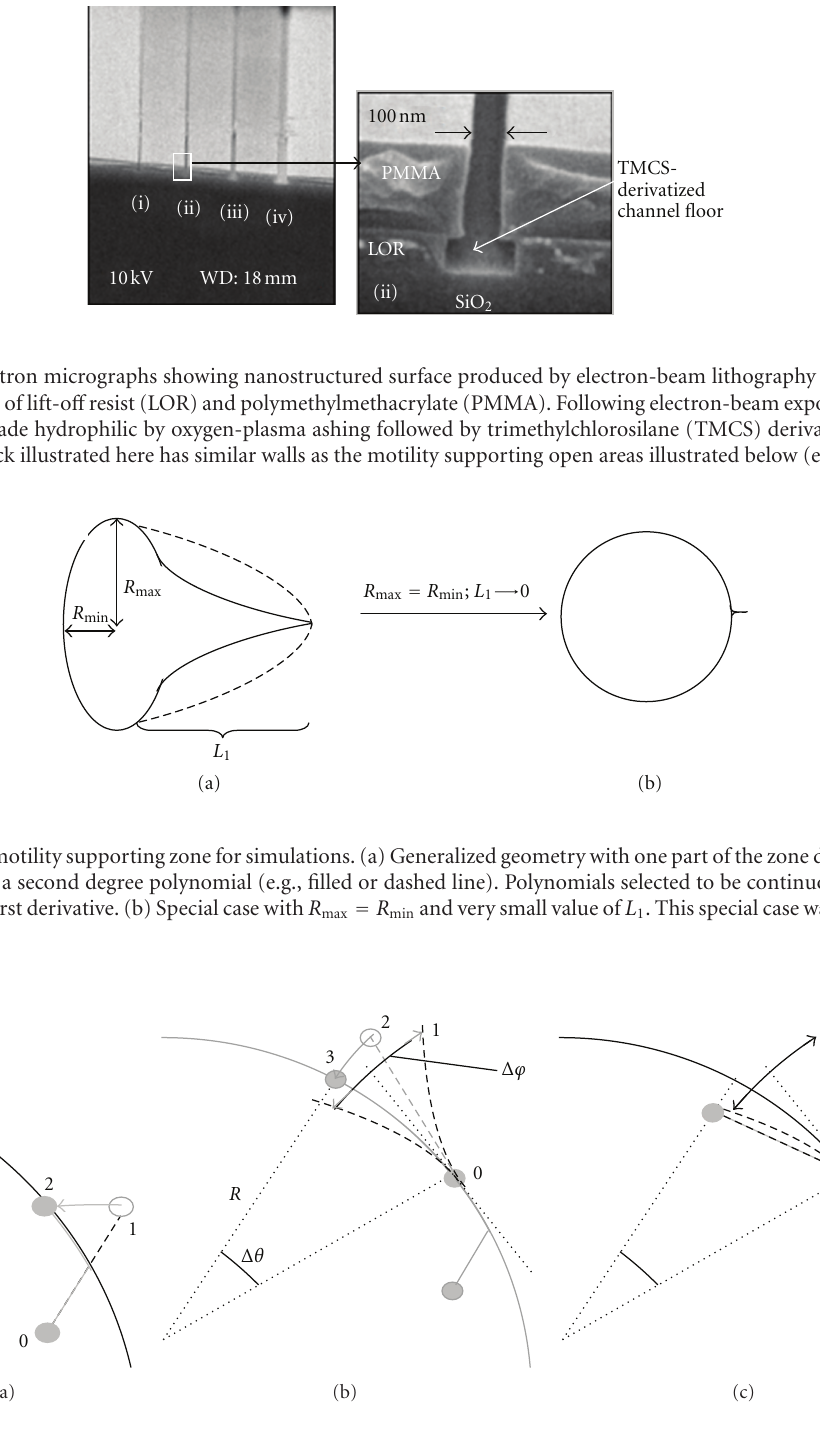
Figure 3: The principle of filament guiding at curved edges in the Monte-Carlo simulations. (a) Filament front (grey filled circle) reaches border from open motility supporting area. Without the border, the position 1 would be attained. In the guiding process, this is shifted to position 2 while ensuring that the total distance moved between positions 0 and 2 is equal to sliding velocity times the simulation time step ( v f Δ t ). (b) Continued guiding along the wall. A new sliding direction is drawn from a Gaussian (with SD as in (1)) under the assumption that the wall is not present. Even if the new position will be outside the wall, the filament front is first moved a distance v f Δ t to that position (2). The filament is then shifted to position 3 on the border in a process that maintains the sliding distance, v f Δ t , between positions 0 and 3. (c) The process if the random update in sliding direction moves the filament away from the border. Note, that the ratio v f Δ t/R is unrealistically large in this example for enhanced clarity in description of the guiding